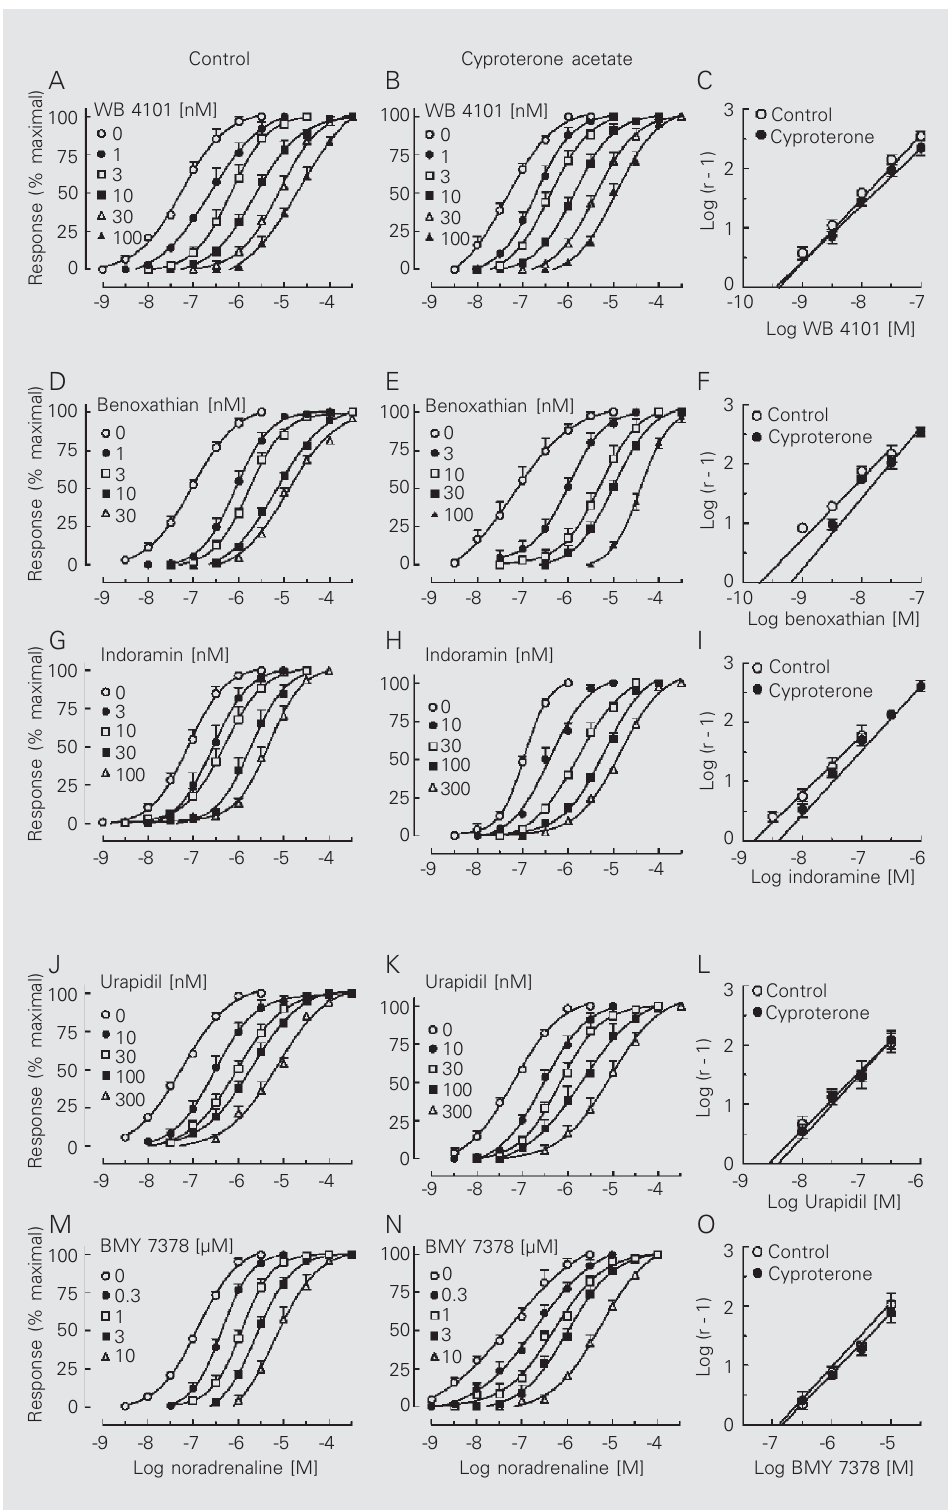
Figure 3. Concentration-re- sponse curves for noradrenaline in the absence and presence of increasing concentrations of WB 4101 (A and B), benoxathian (D and E), indoramin (G and H), 5-methylurapidil (J and K), and BMY 7378 (M and N), in vas deferens from control (A, D, G, J and M) and cyproterone ace- tate-treated rats (B, E, H, K and N). The Schild plots obtained for WB 4101, benoxathian, indora- min, BMY 7378, and 5-methyl- urapidil are presented in C , F , I , L , and O , respectively. Each symbol indicates the mean and the vertical line, when larger than the symbol, the SEM of 4- 12 determinations for 4 to 6 rats in each group. The rats received cyproterone acetate (10 mg/day, sc ) for